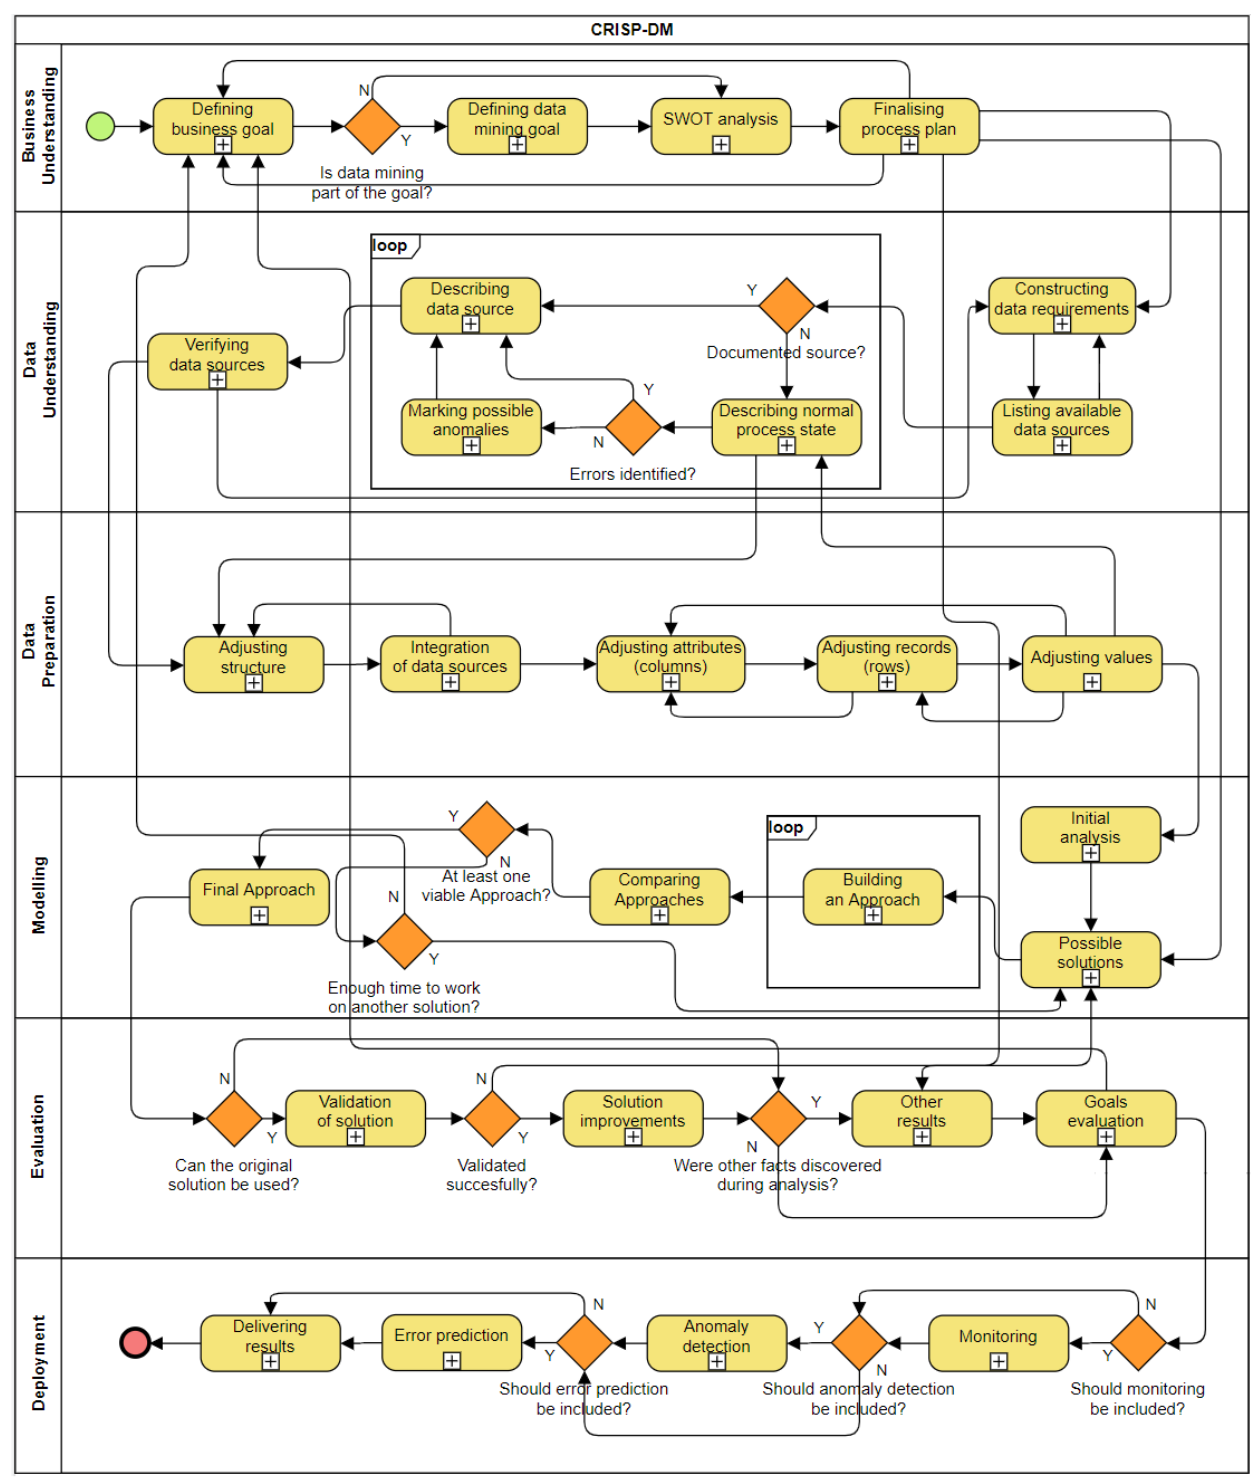
Figure 5. Detailed diagram proposal for integration of phases.